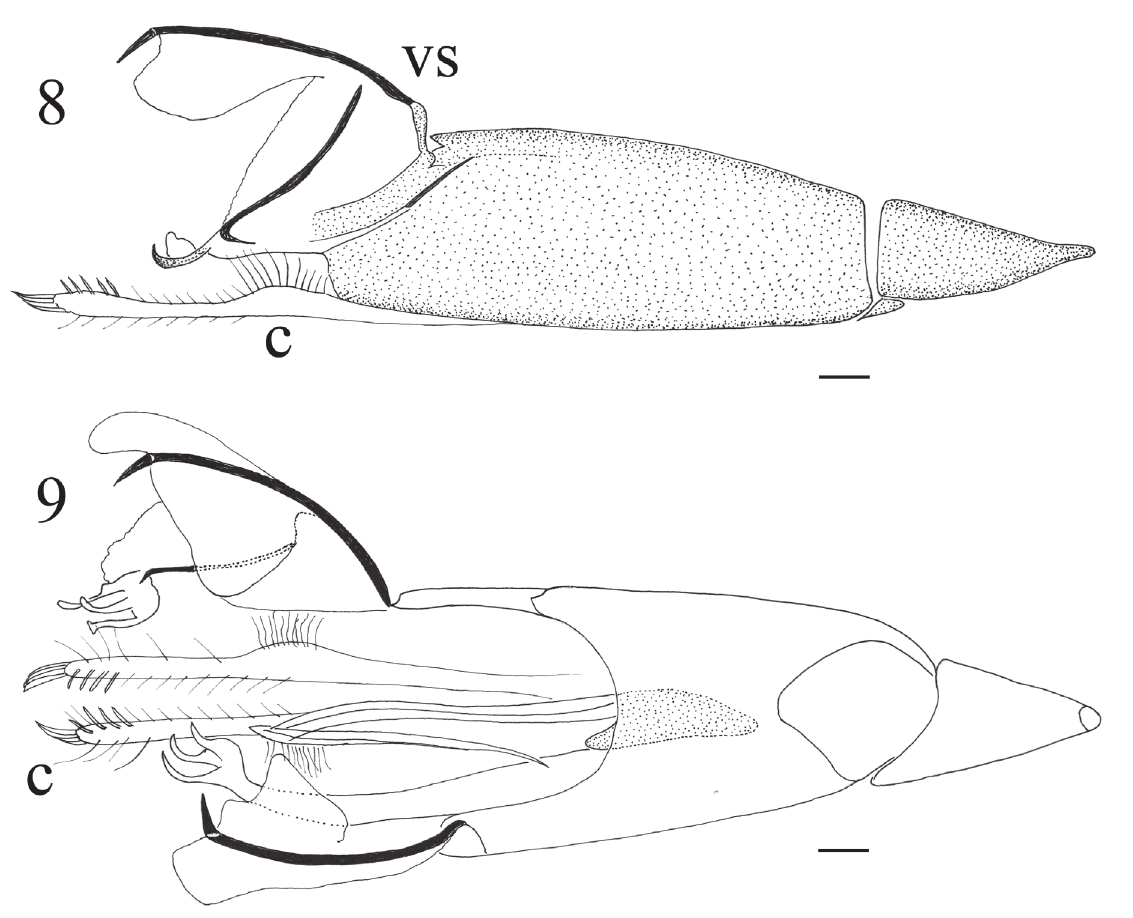
Figs 8–9. Thinophilus langkawensis sp. nov., ♂, terminalia. 8 . Genital capsule, lateral view. 9 . Genital capsule, dorsal